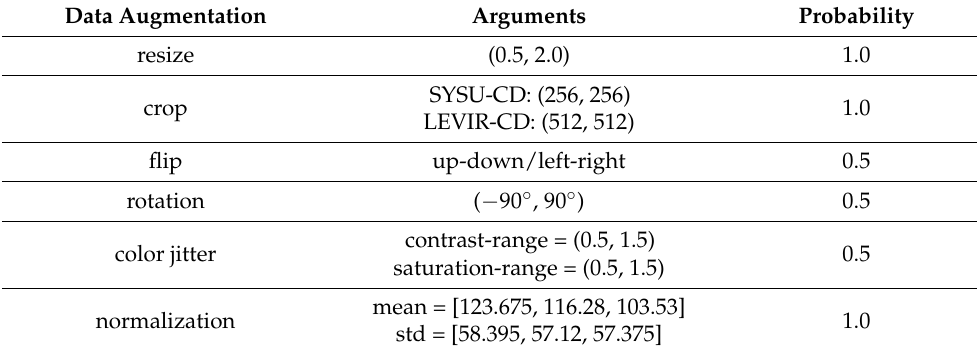
Table 2. Details for data